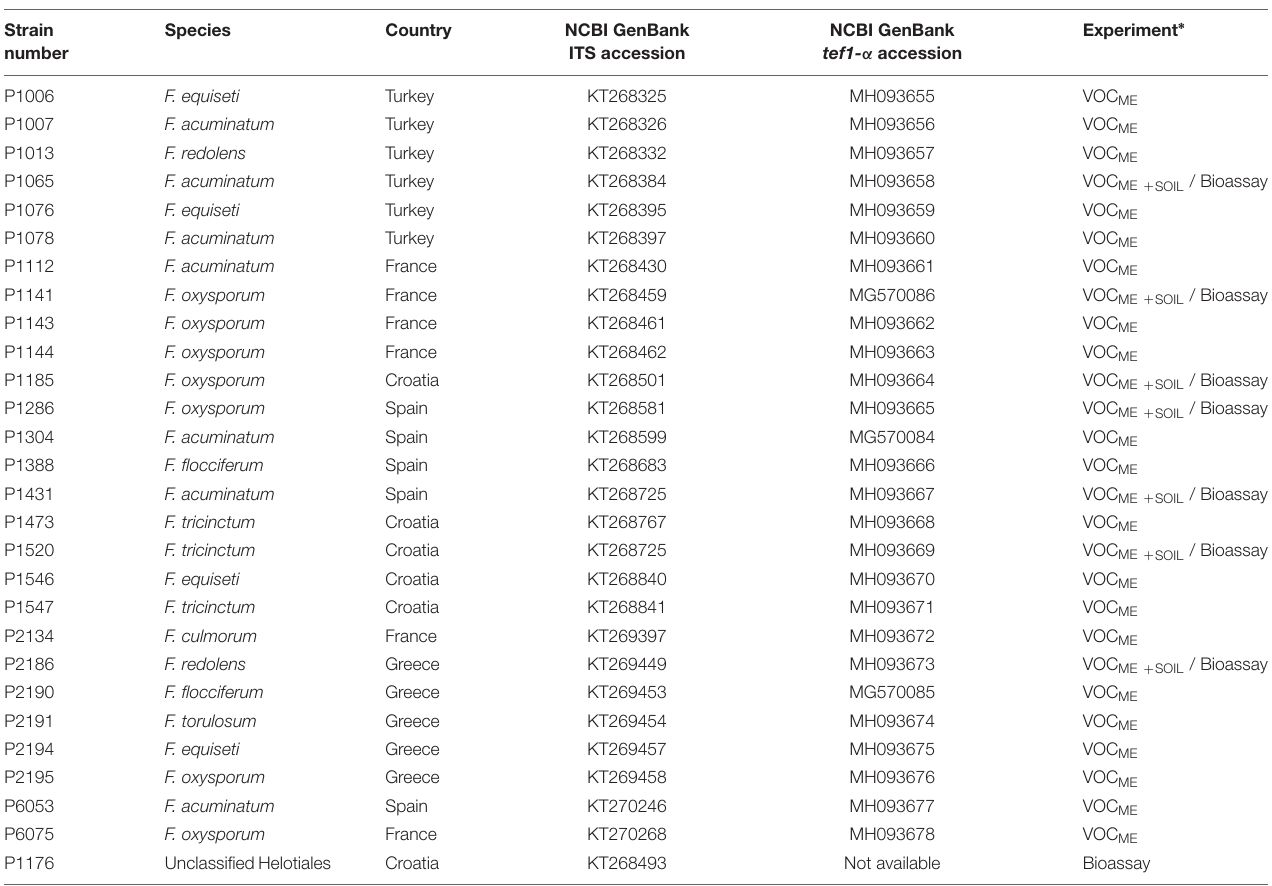
TABLE 1 | Fusarium and Helotiales strains used in this